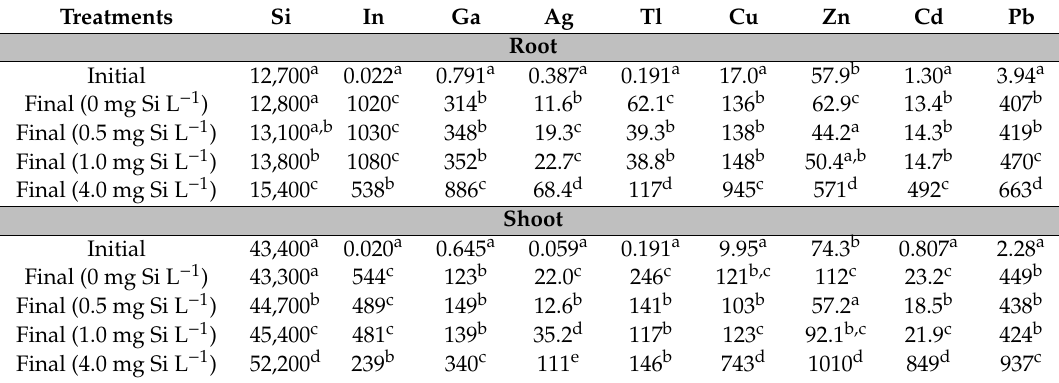
Table 1. Concentrations of Si and heavy metals (mg kg − 1 dry wt) in the roots and shoots of E. acicularis before (initial) and after 21 days of the